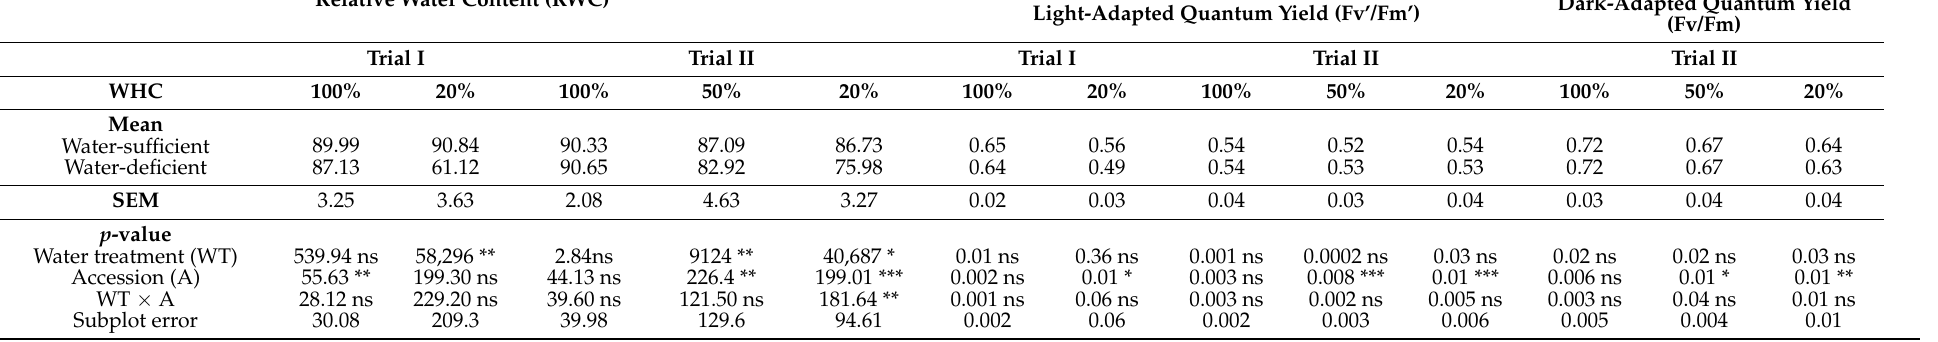
Table 4. Mean and the analysis of variance of water treatment on relative water content and chlorophyll fluorescence in 44 A. tricolor accessions (A) at different water holding capacity (WHC) evaluated in Trial I (n = 3) and Trial II (n = 4). Data represents mean, standard error of mean (SEM), mean square with probability significantly different at p < 0.05 (*), p < 0.01 (**), p